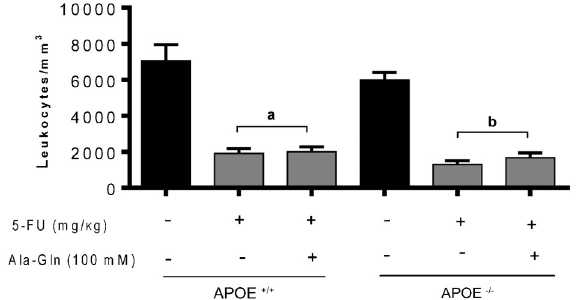
Figure 2. Leukometry results. Mice were anesthetized and blood samples were collected 5 days after 5-fluorouracil (5-FU) chal- lenge. The total number of white cells was determined after dilution in Turk’s solution using a Neubauer chamber. Data are reported as means±SEM of the number of leukocytes per mL of sample (n=7 animals/group). a P , 0.001 vs unchallenged wild-type (APOE +/++ ) mice. b P , 0.001 vs unchallenged APOE knockout (APOE -/- ) mice (one-way ANOVA, followed by the Bonferroni multiple test).